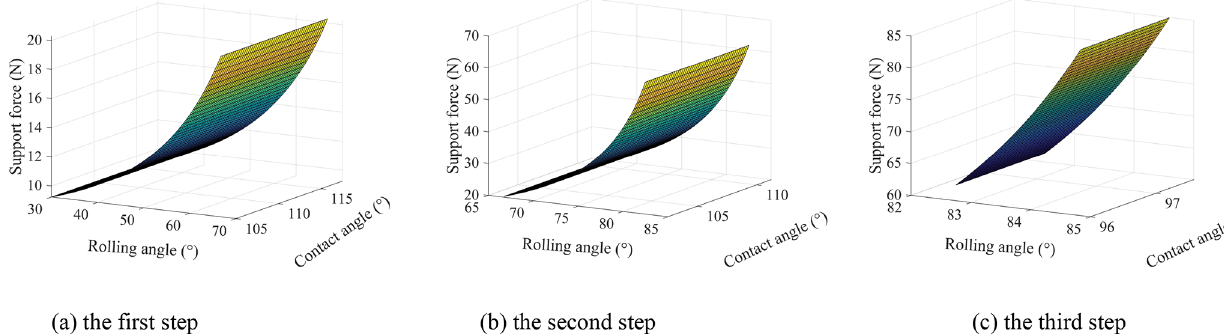
Figure 13. The variation of support force of steps on the main